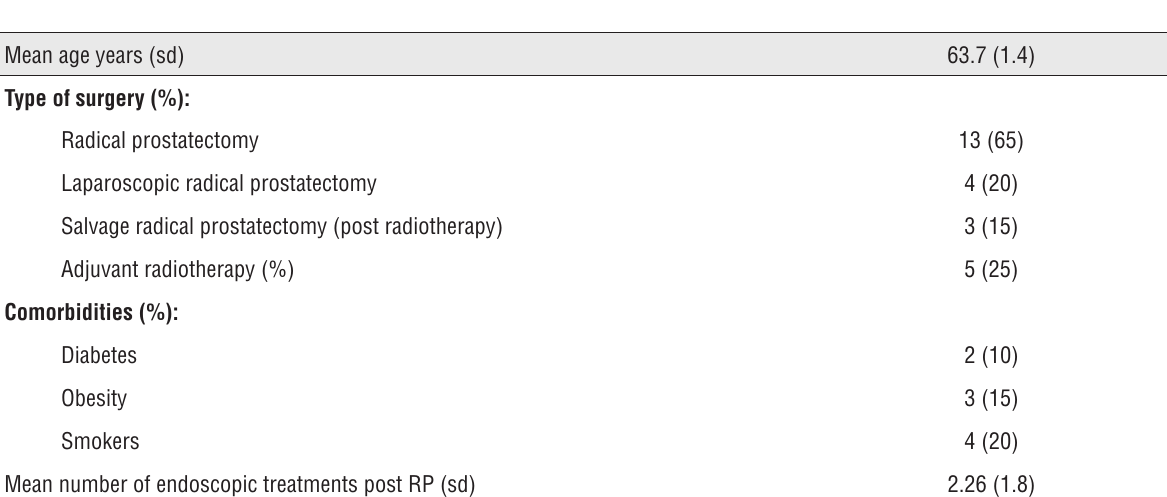
Table 1 - Demographic data.